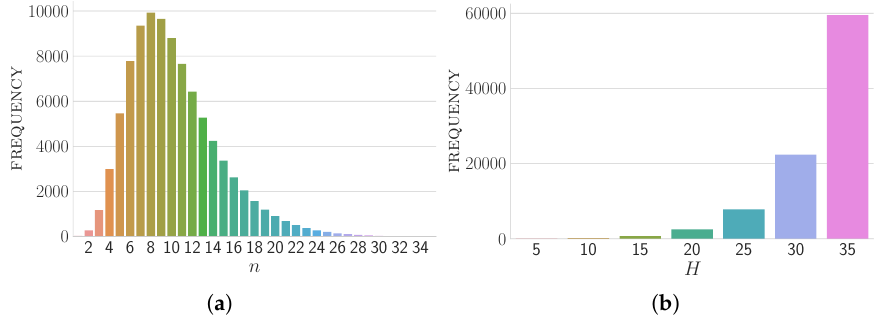
Figure 2. ( a ) Distribution of instances with respect to n for all partitions of integer H ∈ { 5,10, 15,20,25, 30,35 } ; and ( b ) distribution of instances with respect to H for all partitions of integer H ∈ { 5,10,15,20,25,30,35 } .